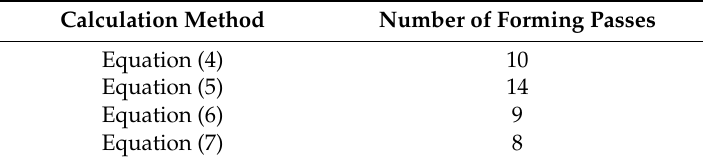
Table 4. Comparison of calculation methods on forming passes.